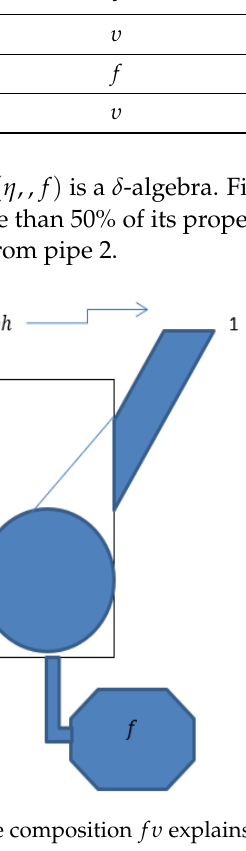
Figure 3. The composition 𝑓𝜊𝜐 explains when 𝑓 is entered from pipe 1.